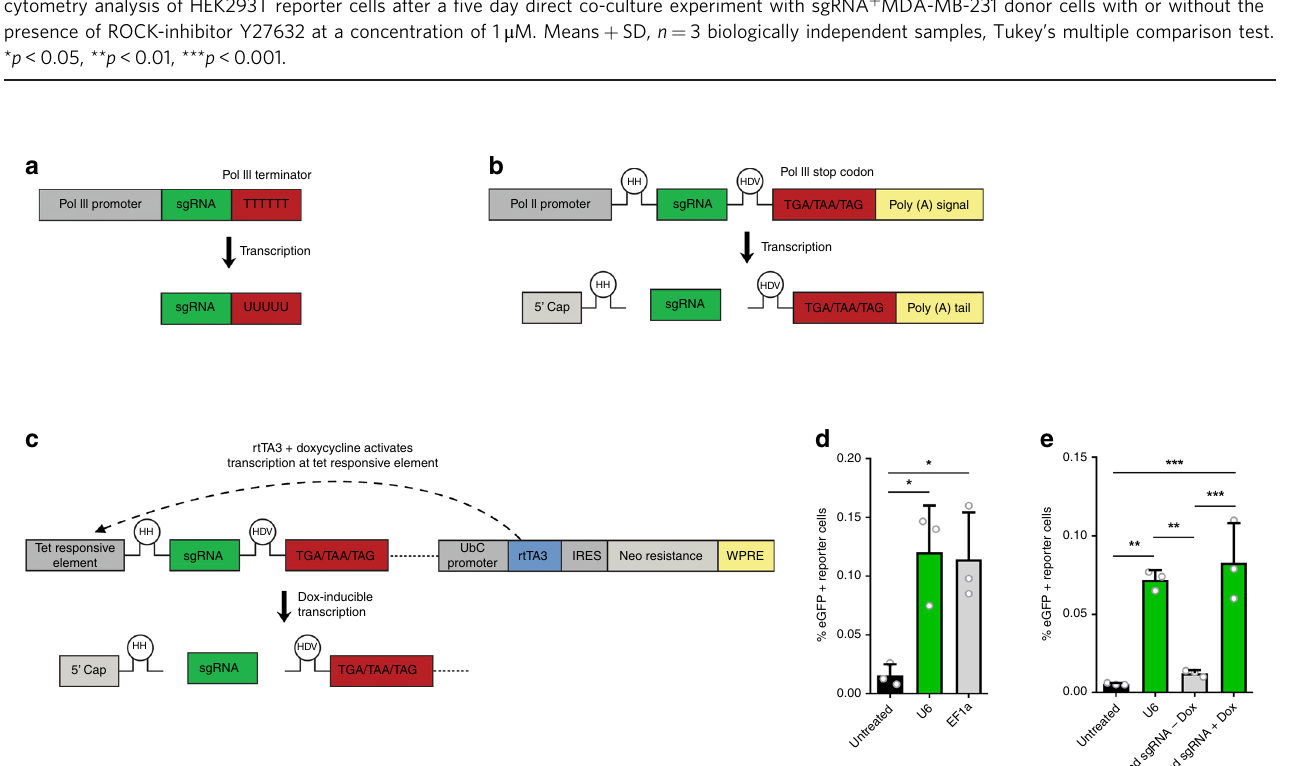
Fig. 4 Analysis of cellular pathways to study EV-mediated RNA transfer and uptake. a Work fl ow to study the role of speci fi c genetic targets in intercellular RNA transfer using the CROSS-FIRE system. b Flow cytometry analysis of HEK293T Stoplight + spCas9 + reporter cells after a fi ve day co- culture with sgRNA + MDA-MB-231 donor cells subjected to siRNA-mediated KD of genes as compared to a non-targeting negative control siRNA (NC). Means + SD, n = 5 independent experiments, Dunnett ’ s multiple comparison test. c Flow cytometry analysis of HEK293T Stoplight + spCas9 + reporter cells after a fi ve day co-culture with sgRNA + MDA-MB-231 donor cells, in which HEK293T reporter cells were subjected to siRNA-mediated KD of various genes as compared to a non-coding control siRNA (NC). Means + SD, n = 4 independent experiments, Dunnett ’ s multiple comparison test. d Schematic of work fl ow to study the role of genes involved in EV-mediated RNA delivery. e Flow cytometry analysis of Stoplight + spCas9 + HEK293T reporter cells treated for six consecutive days with sgRNA + MDA-MB-231-derived EVs after transfection with a non-coding siRNA (NC), or siRNAs targeting Cav1, as compared to vehicle-treated reporter cells (PBS). EVs were added every 24 h for six additions with an average concentration of 1.8e11 ± 1.1e11 EVs per addition. Means + SD, n = 3 biological replicates, Tukey ’ s multiple comparison test. f Flow cytometry analysis of HEK293T Stoplight + spCas9 + reporter